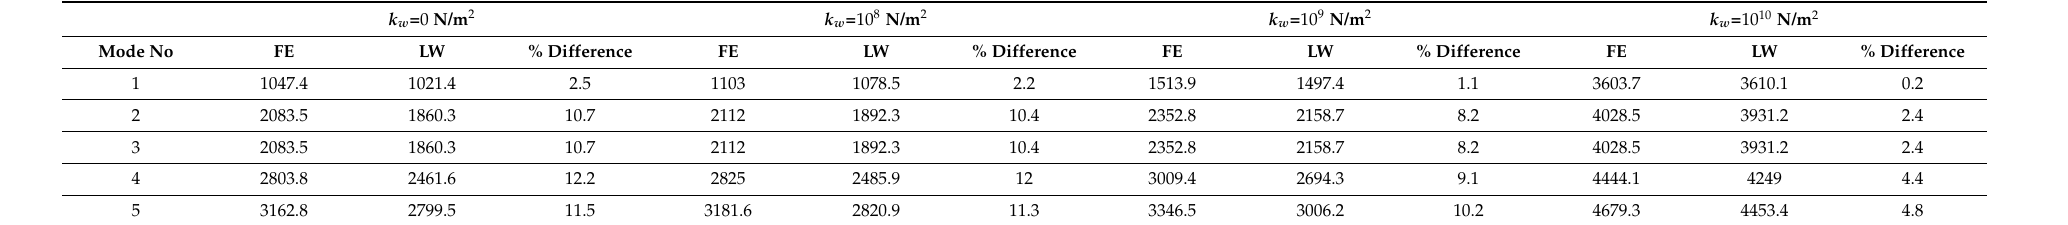
Table 11. Comparison of frequencies (HZ) based on LT and those FE findings for different elastic foundations. n = 1, a h